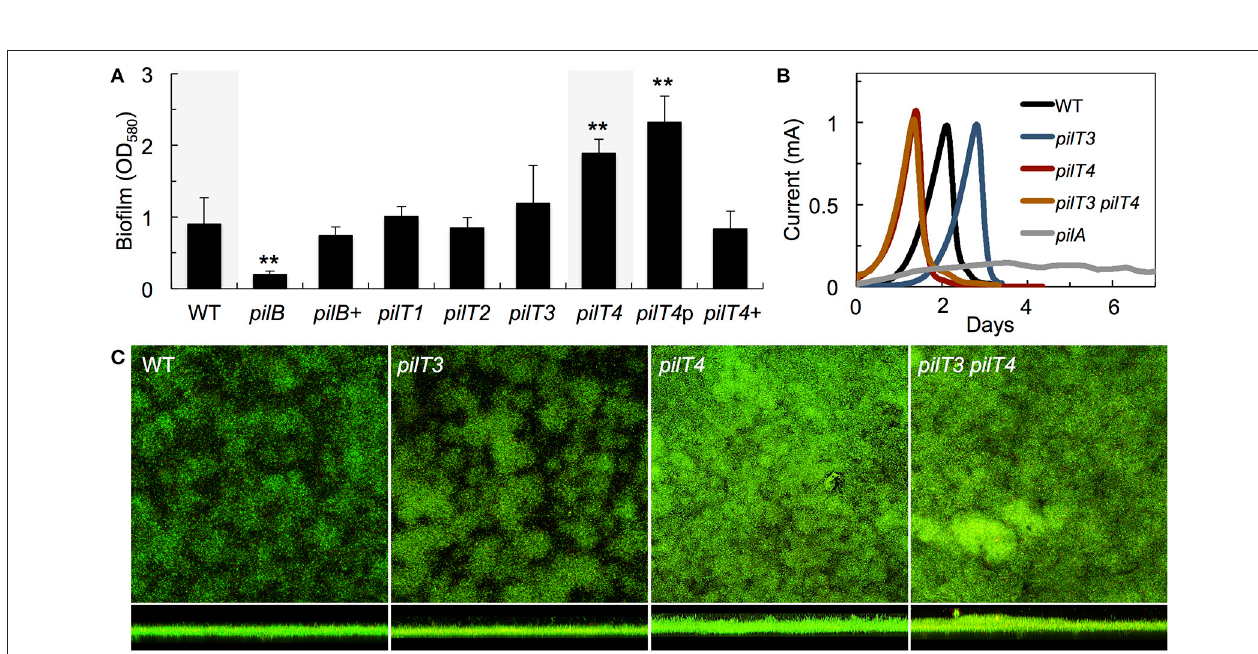
FIGURE 5 | Biofilm formation on plastic surfaces (A) and on poised electrodes (B,C) by WT and pilT mutants of G. sulfurreducens . (A) Biomass of 48-h biofilms of a pilus-deficient pilB mutant, its complemented strain pilB + , and mutants carrying a deletion in one of the pilT paralogs ( pilT1 - 4 ) relative to the WT strain. The biofilm biomass of a genetically complemented pilT4 + strain and pilT4 p control strain carrying the empty plasmid are also shown. Data are the average and standard deviation of four biological replicates, each containing six technical replicates. Statistically significant changes were determined in two-tailed pairwise comparisons with the WT or PAK 1 pilT -p strains using the t -test function of the Microsoft ® Excel ® software (** p < 0.001). (B) Current production by anode biofilms in MECs fed an initial concentration of 1 mM acetate and driven by the WT, pilT3 , pilT4 , and pilT3 pilT4 strains in reference to the pilin-deficient mutant pilA . (C) Confocal micrographs (200 × 200 µ m2) showing top and side view projections of current-producing anode biofilms collected from MECs in (B) and stained with the BacLight viability dies (green, live cells; red, dead cells).